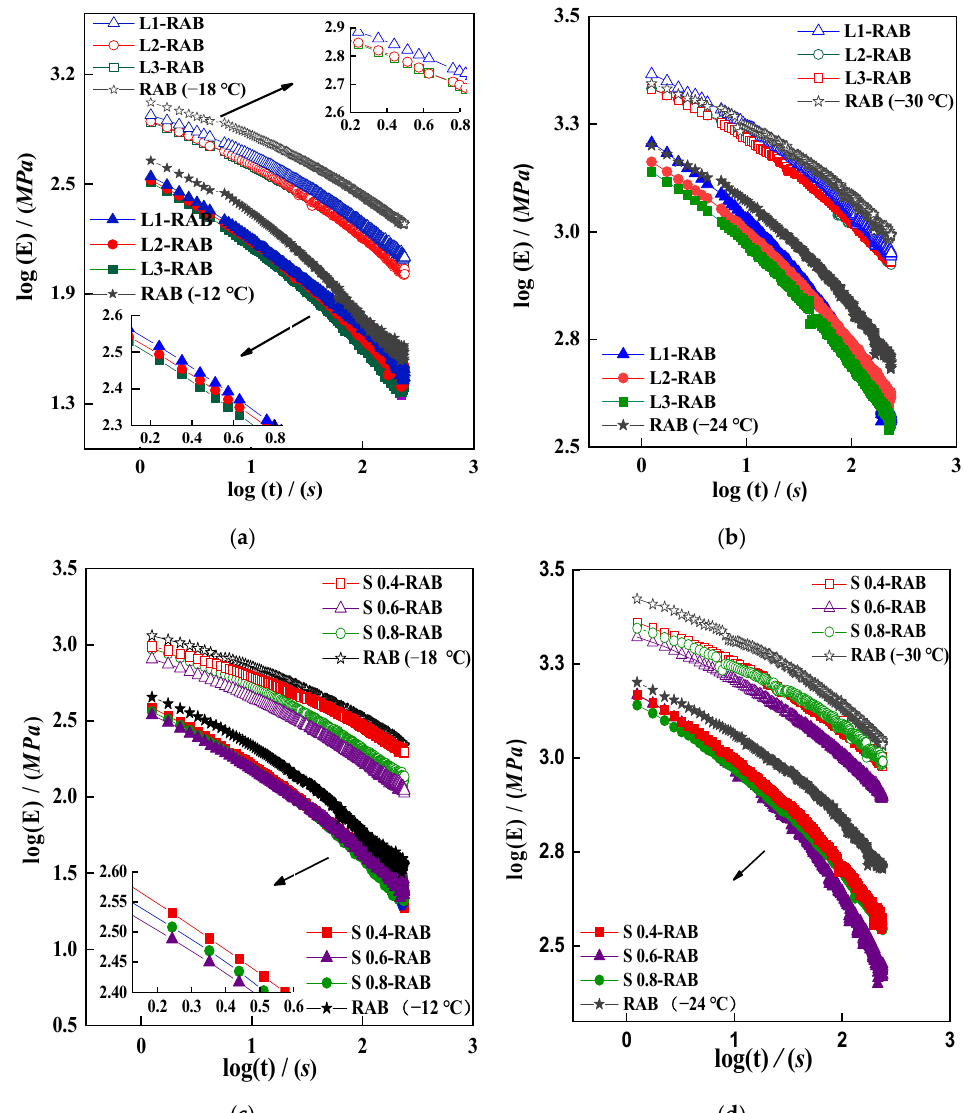
Figure 5. 𝐸(𝑡) curves of W-RABs at − 12 ℃ , − 18 ℃, − 24 ℃ , − 30 ℃ . ( a ) L-RABs at − 12 ℃ and − 18 ℃ ; ( b ) L-RABs at − 24 ℃ and − 30 ℃ ; ( c ) S-RABs at − 12 ℃ and − 18 ℃ ; ( d ) S-RABs at − 24 ℃ and − 30 ℃ . − 18 ◦ C; ( b ) L-RABs at − 24 ◦ C and − 30 ◦ C; ( c ) S-RABs at − 12 ◦ C and − 18 ◦ C; ( d ) S-RABs at − 24 ◦ C and − 30 ◦